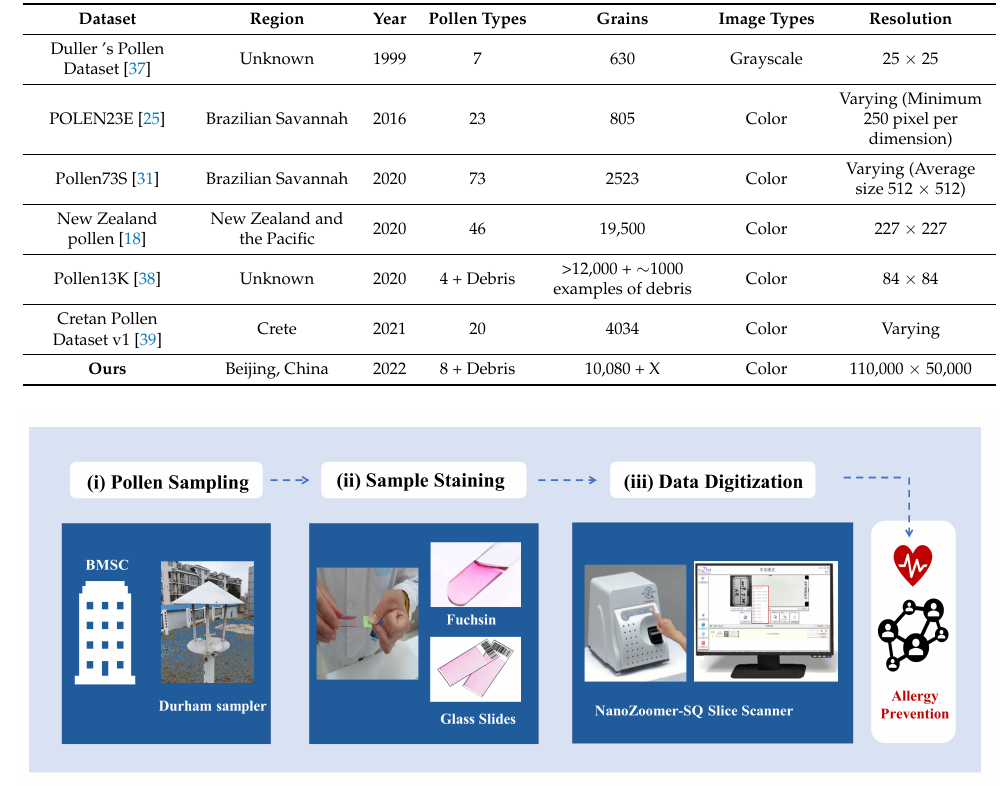
Figure 2. The overall acquisition processing of pollen